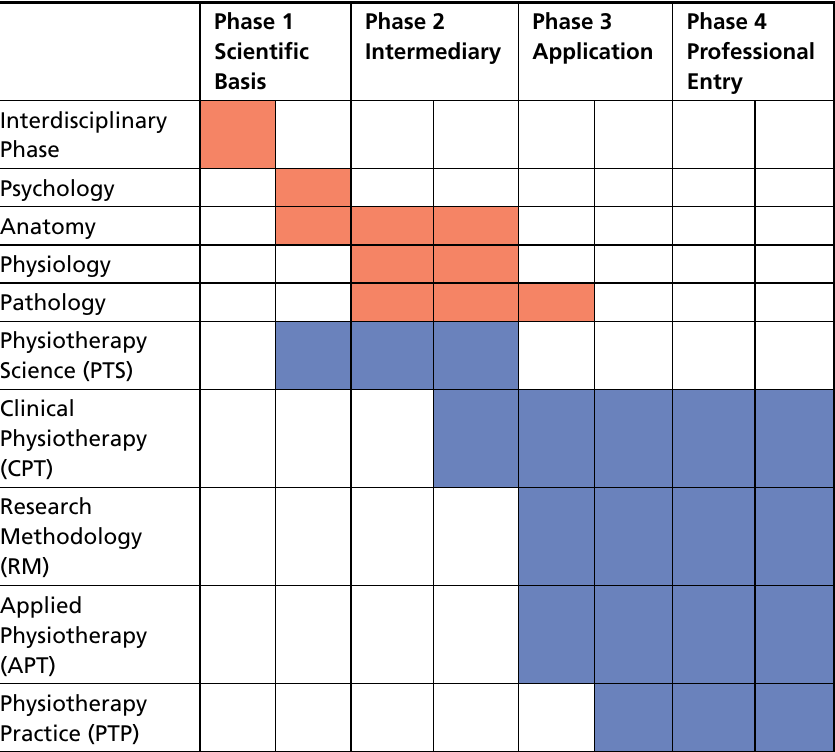
table 1: schematic representation of the 4 Phases of the Physiotherapy curri- culum at stellenbosch